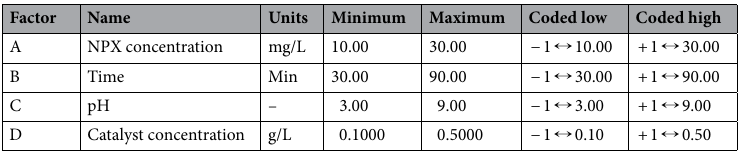
Table 2. Operating parameters for degradation of naproxen experiment.